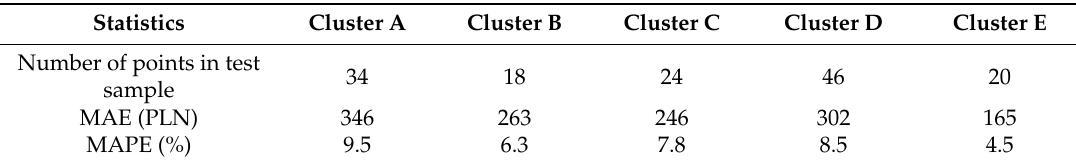
Table 6. Errors of estimating property